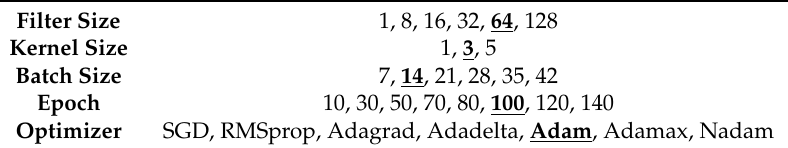
Table 3. Optimization of